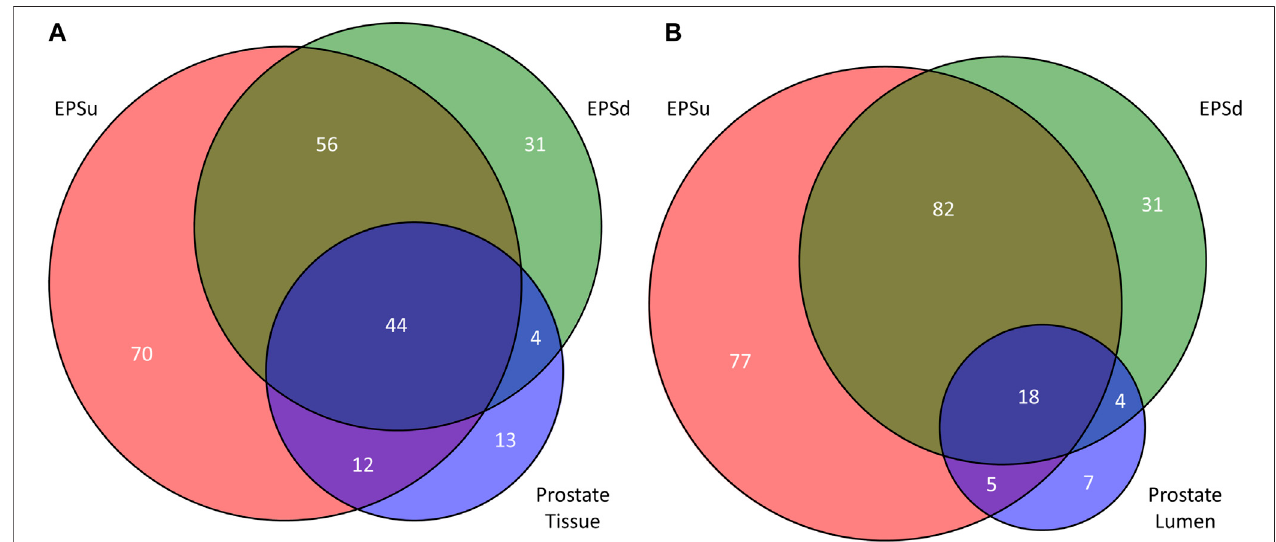
FIGURE 7 | Comparison of detected N-glycans across sample sets. (A) The number of unique and common N-glycans detected in EPSu, EPSd, and across the entire prostate tissues. (B) The number of unique and common N-glycans detected in EPSu, EPSd, and within the lumen of the prostate tissues.